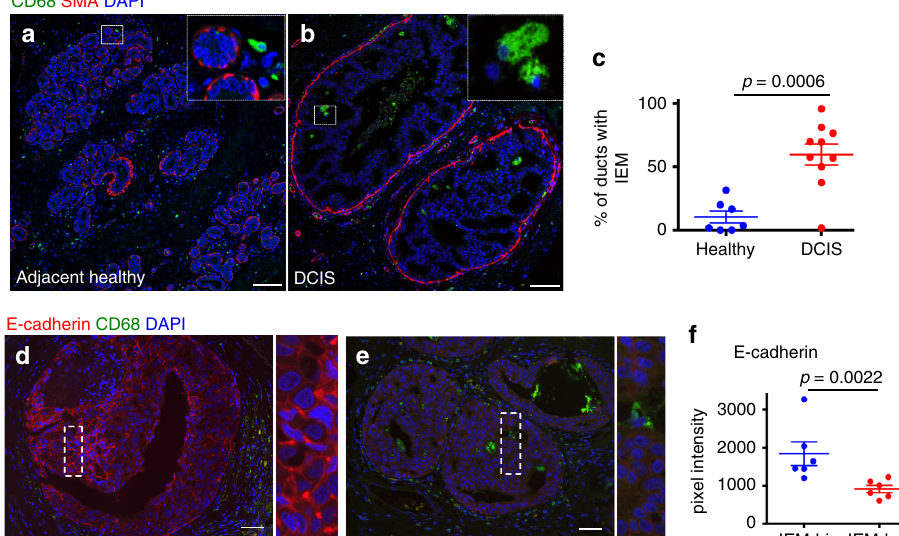
Fig. 7 Intra-epithelial macrophage numbers in human DCIS lesions negatively correlate with E-cadherin levels. Human adjacent healthy ( a ) and DCIS tissue ( b ) was stained against CD68 (macrophages) and smooth muscle actin (SMA). Bar: 75 μ m; zoom factor 4.75x. c Plot shows mean ± SEM of the percentage of ducts containing intra-epithelial macrophages (IEMs) from 7 healthy and 10 DCIS patients; each dot represents one patient; statistical analysis: Mann – Whitney test. Sections from human DCIS tissue were stained against CD68 (macrophages) and E-cadherin ( d , e , bar: 75 μ m; zoom factor 4.1x). E- cadherin pixel intensity was quanti fi ed in regions of individual cell junctions and medians for individual patients were quanti fi ed. Plot f depicts mean E- cadherin intensity throughout DCIS lesions of individual patients with low or high intra-epithelial macrophage (IEM) numbers (total patient number N =